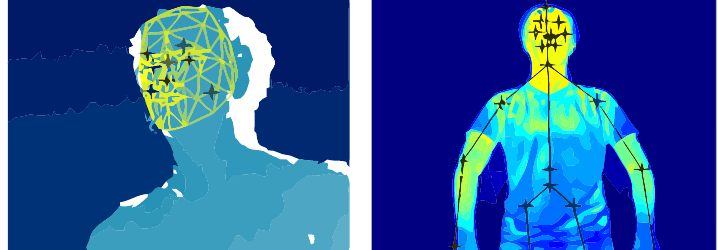
Figure 1. Face and pose tracking; left: depth image of face, right: thermal image of body and face, redrawn from